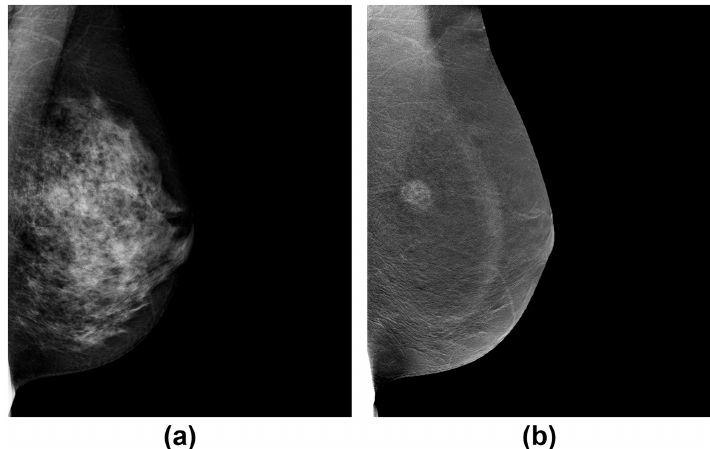
Figure 2. An example of a mammographically occult mass in a dense breast ( a ) on the low-energy image but is demonstrated on the dual-energy recombined contrast-enhanced image ( b ) (CESM).